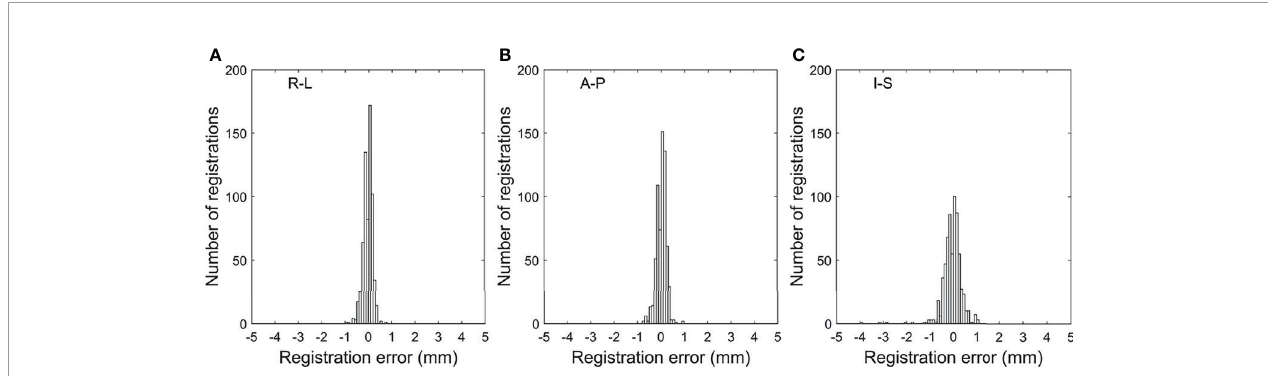
FIGURE 6 | Histograms of the all-phase fi ducial marker registration errors by the template matching-based image registration performed for the patient data in the (A) R-L, (B) A-P, and (C) I-S directions. R-L, right-left; A-P, anterior-posterior; I-S,